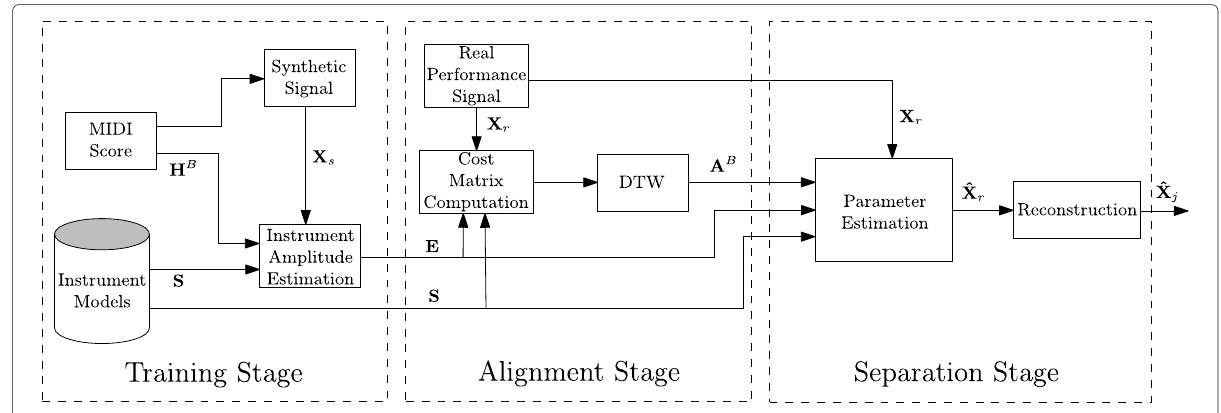
Fig. 1 Block diagram of the proposed